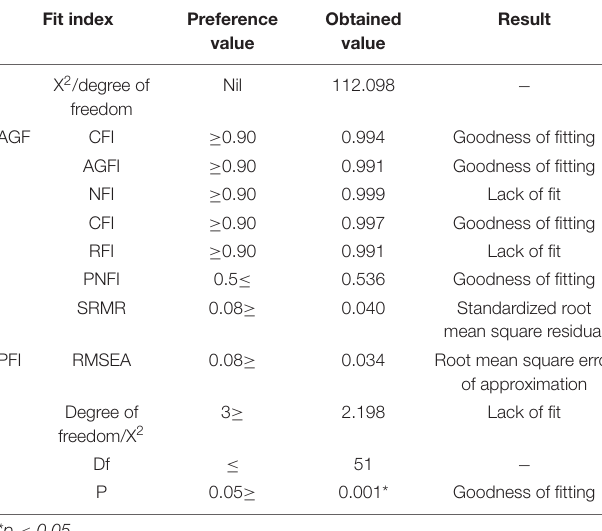
TABLE 5 | Goodness-of-fit indices of the writing self-efficacy (WSE) before revision.